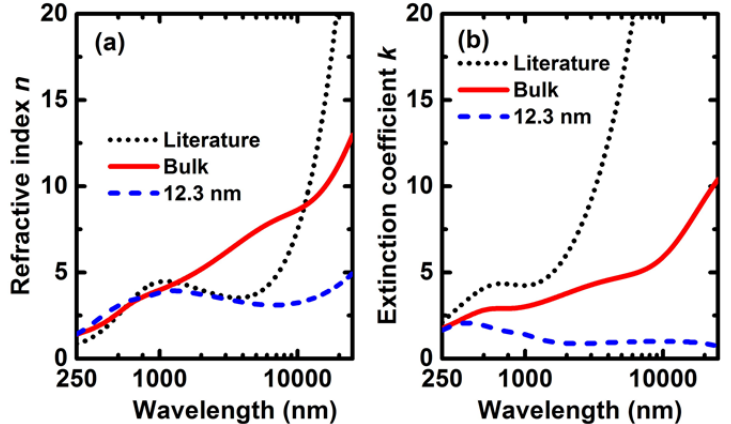
Figure 3. Optical constants ( a ) refractive index n , and ( b ) extinction coefficient k of the fabricated Cr samples, in comparison with the reference [30].